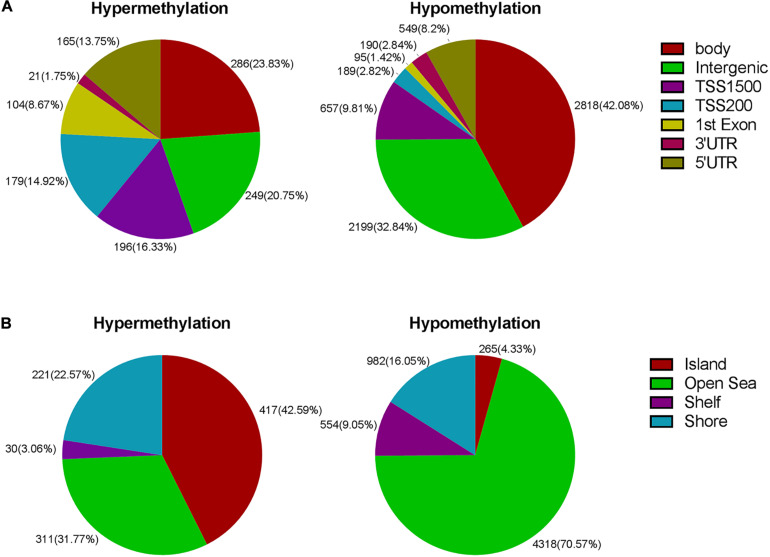
(A) Frequency of differentially methylated regions according to functional distribution. (B) Frequency of differentially methylated sites according to CpG island contextual distribution.